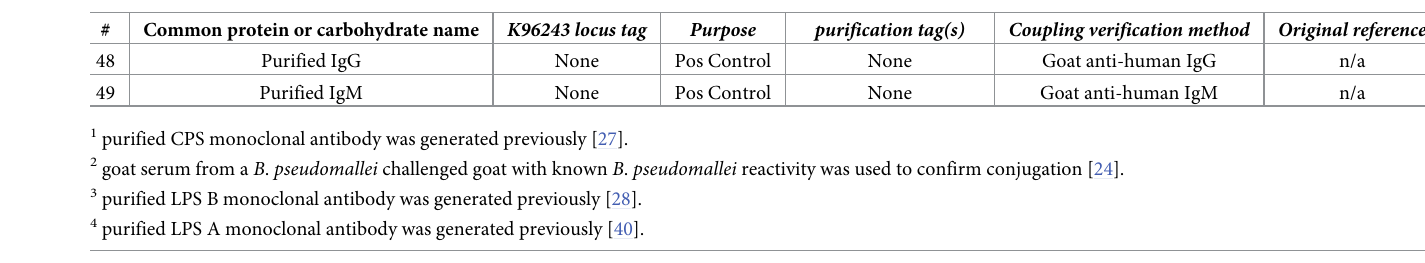
patient samples collected over time. In addition, the IgG antibody response in melioidosis patients was higher over time compared to the IgM response in the same patient samples signal intensity overlap for both IgG and IgM measured responses between negative and melioidosis samples. The overlap of reactive antibody signal could lead to false positive and negative serum samples if using the B . pseudomallei WCL ELISA to diagnose melioidosis. For IgM, 81% of the first melioidosis samples overlap with the negative sample antibody reactivity and this decreases down to 61% or 71% for later collected samples. For IgG reactivity, a similar but smaller overlap of 37% of collected samples has similar antibody reactivity compared to negative samples for the first sample and the number of sample overlap decreases to 9–10% at later time points. For the negative samples, 83% of the negative samples end up in this overlap reactive zone for IgM and 56% for IgG reactivity. Thus, early melioidosis patient samples col- lected after admission are more difficult to distinguish from the non-melioidosis serum sam- ples. Using the WCL ELISAs antibody reactivity data and the overlap zone, we selected a set of serum samples (Total 188 samples) from the non-melioidosis group (Fig 1 squares , 76 sam- ples) and melioidosis groups (n = 56 individuals, 112 paired samples) to evaluate a multiplex serology assay and perform subsequent analysis. These samples were selected to increase strin-